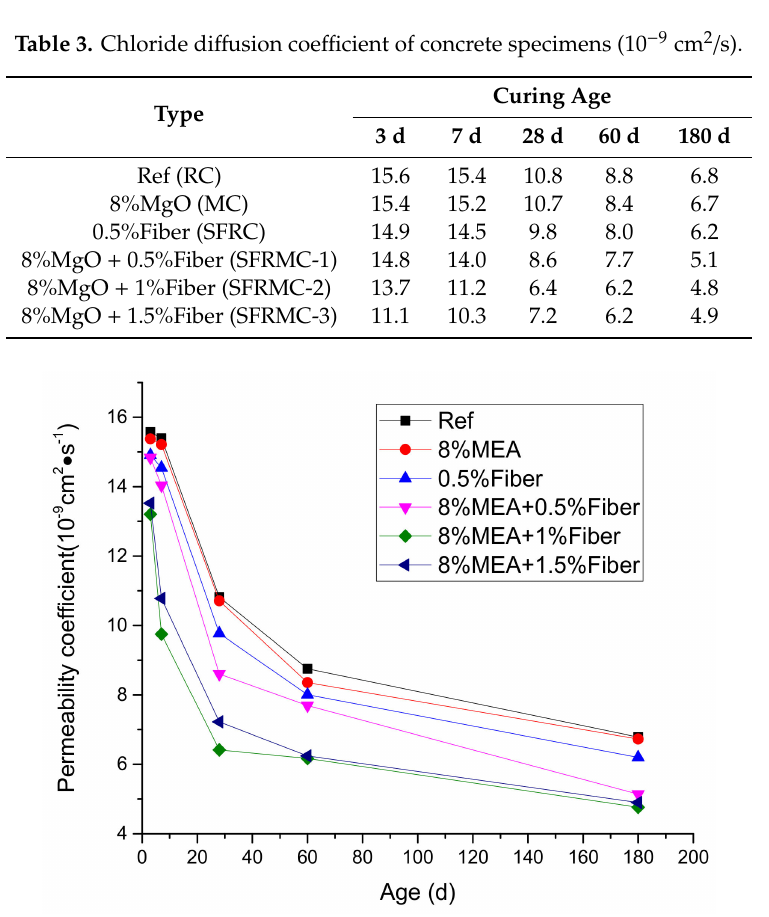
Figure 8. Changes of chloride di ff usion coe ffi